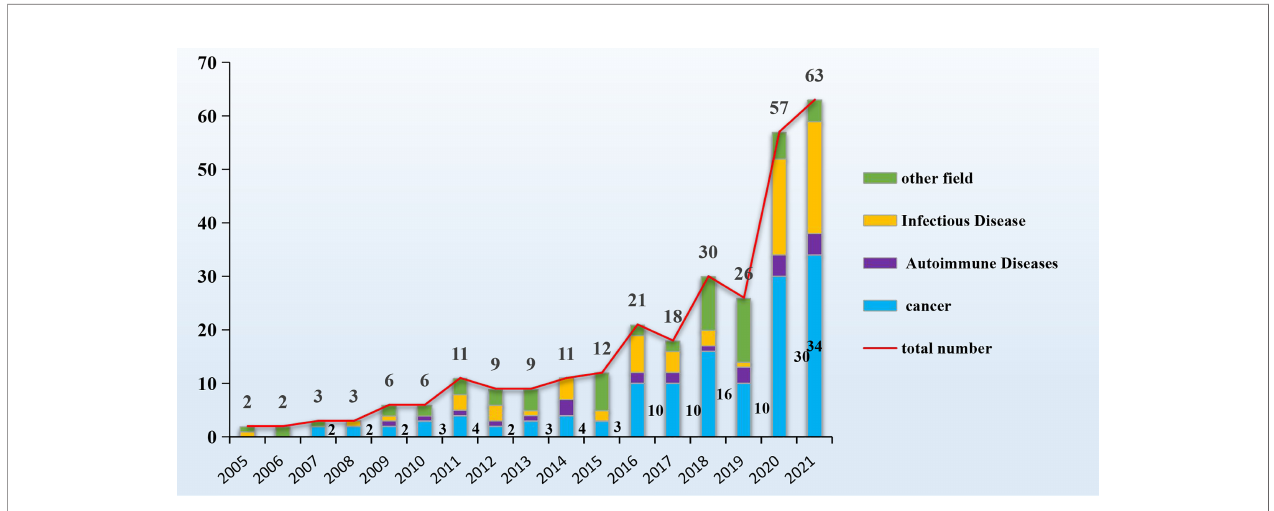
FIGURE 2 | Timeline of conceptual and technical innovations contributing to the development of the multi-function nanobody landscape. The Camelidae “ heavy- chain-only antibodies ” were fi rst reported by Hamers-Casterman et al. (7) in 1993 and the fi rst bispeci fi c antibody (Catumaxomab) was approved by EMA only in 2009 (56). In 2014, the fi rst bispeci fi c scFv (Blinatumomab) was approved by FDA (57) and the same agency approved, the fi rst bivalent nanobody drug (Caplacizumab) for treatment of acquired thrombotic thrombocytopenic purpura (TTP) in 2019